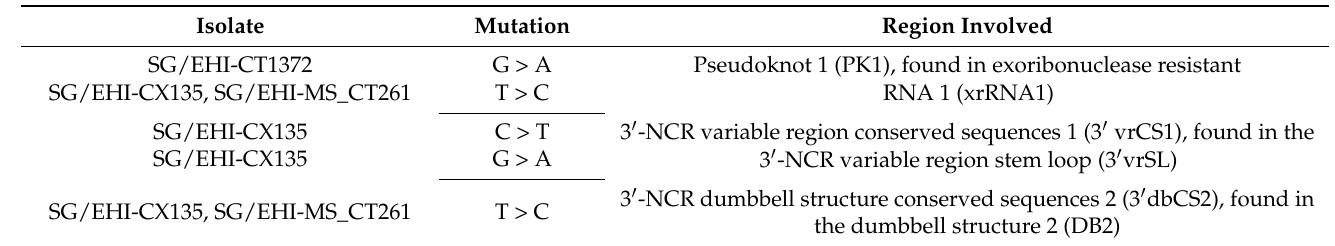
Table 5. Mutations involved in significant regions of 3 (cid:48) -NCR secondary structures belonging to the JEV isolates in this